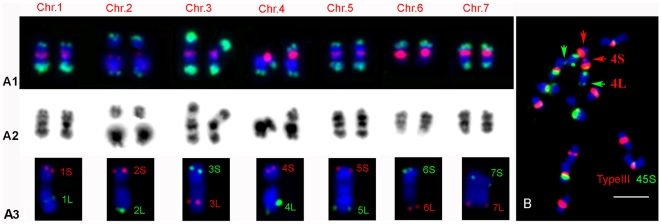
Integration of the seven linkage groups of cucumber with individual chromosomes.(A1) Distribution of Type I/II (green) and Type III (red) repeats on cucumber chromosomes. (A2) DAPI staining was converted to black and white images. (A3) Localization of chromosome-specific fosmid clones on both arms of individual chromosomes, genetic location of arm-specific fosmid clones are indicated in Figure 2. (B) Localization of fosmids 4S (red) and 4L (green) together with Type III (red) and 45S rDNA (green) repeats on the mitotic chromosomes. Bar = 2.5 µm.